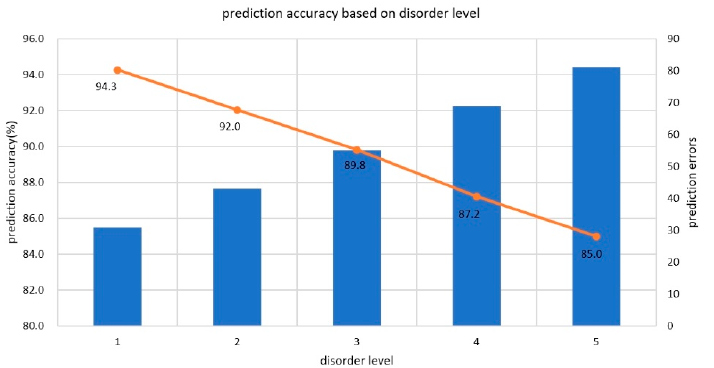
Figure 6. The prediction accuracy based on 5 disordered levels.